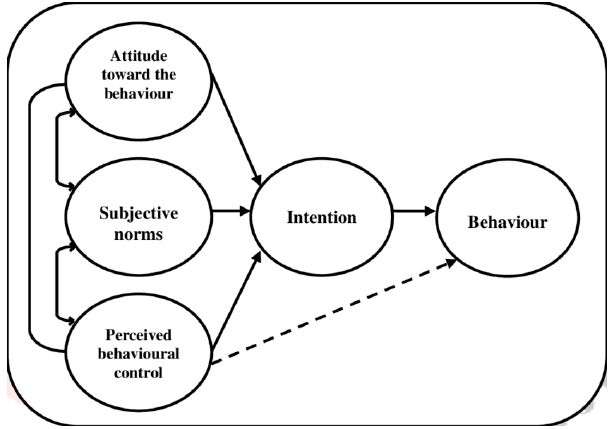
Figure 1. Theory of planned behavior [52]